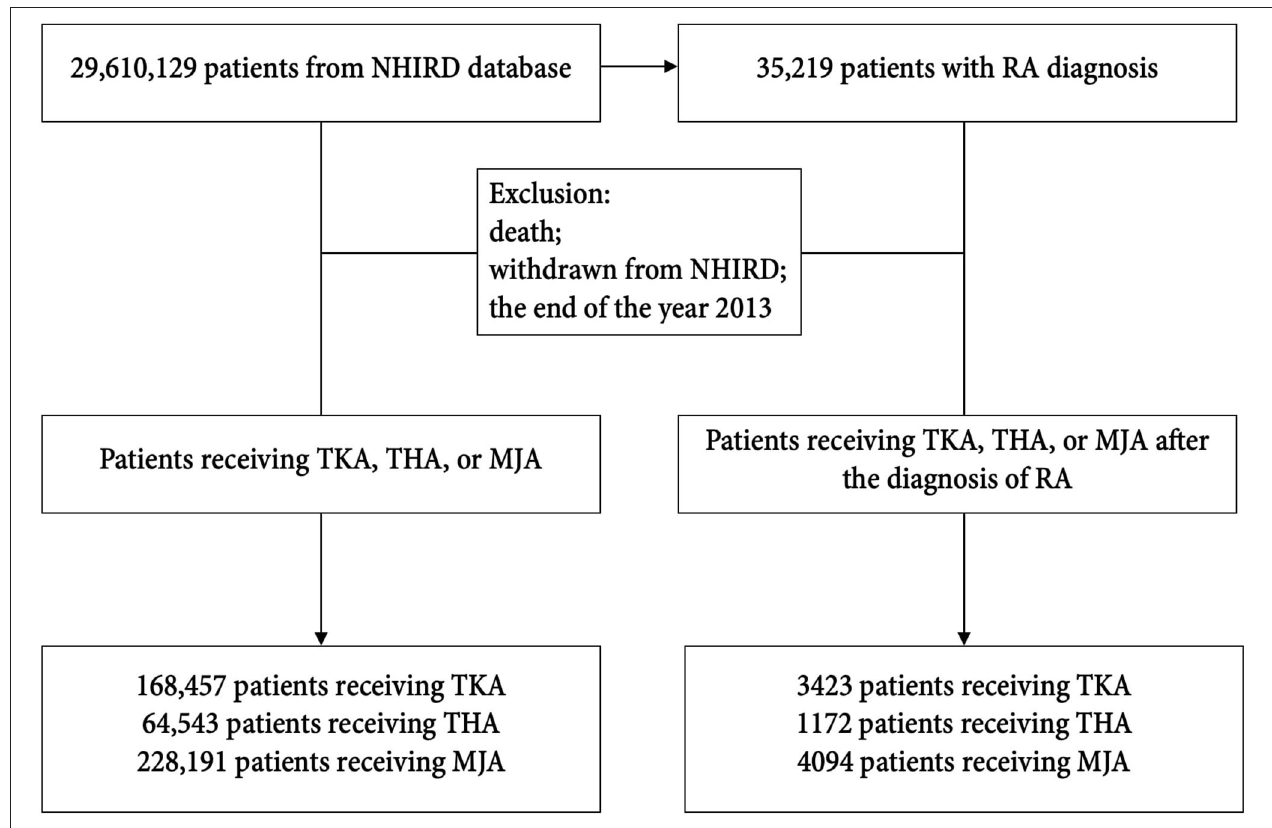
FIGURE 1 | Flowchart of the study selection process.